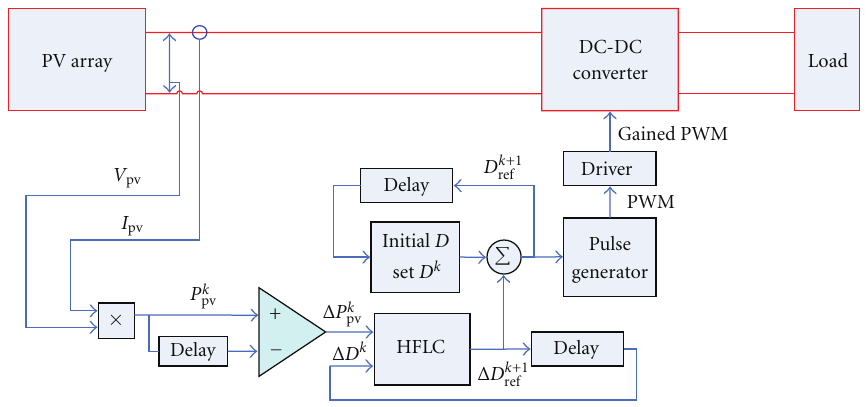
Figure 8: Physical implementation of PV MPPT system using HFLC.